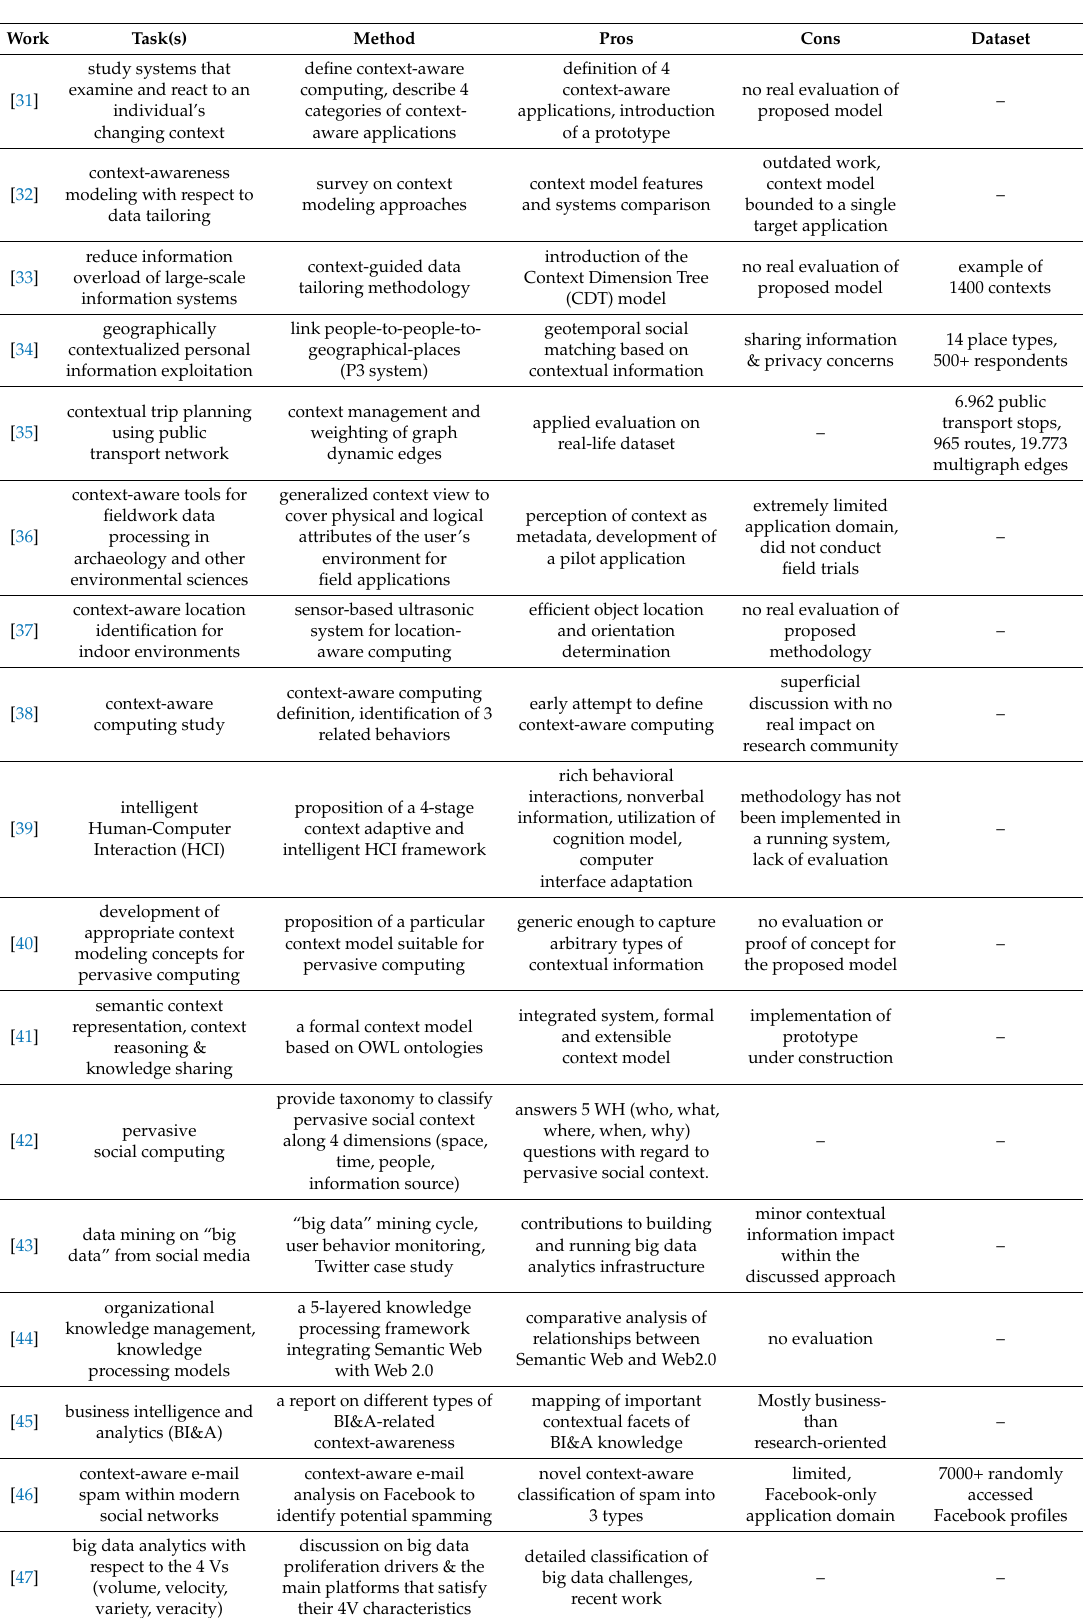
Table 4. Context-awareness